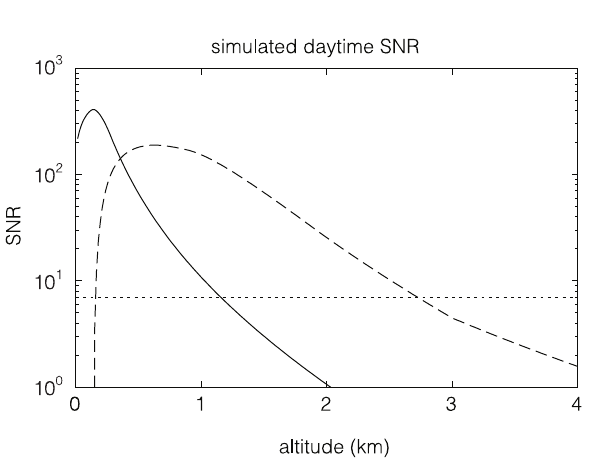
Fig. 3. Simulated SNR in daytime for 2 min integra- tion time with the small telescope (solid line), and for 30 min integration time with the large telescope (dashed line). The thin dotted line denotes the SNR = 7 level.